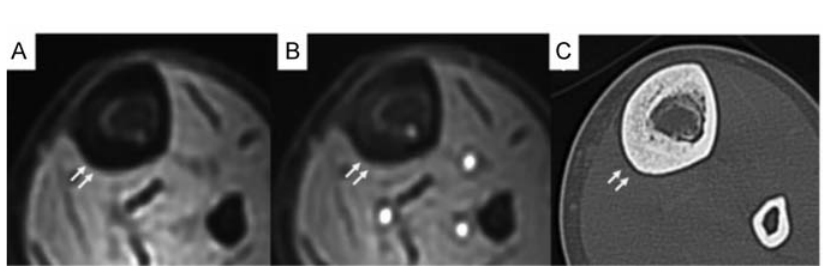
Figure 3. Repeat computed tomography and magnetic resonance imaging indicate radio- logical resolution of the nidus 2.5 years after initial presentation. A) Fat-suppressed T1- weighted magnetic resonance image: 30 months after initial presentation. B) Gadolinium enhanced fat-suppressed T1-weighted magnetic resonance image: 30 months after initial presentation. C) Axial computed tomography image: 30 months after initial